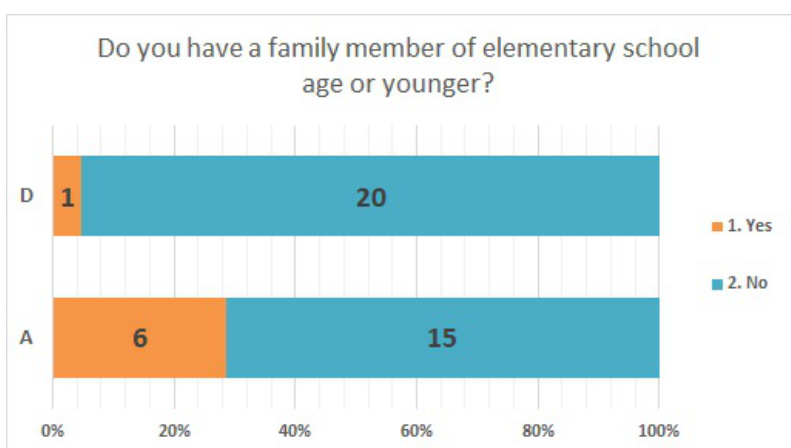
Figure 4. Presence of children of elementary school age or younger.